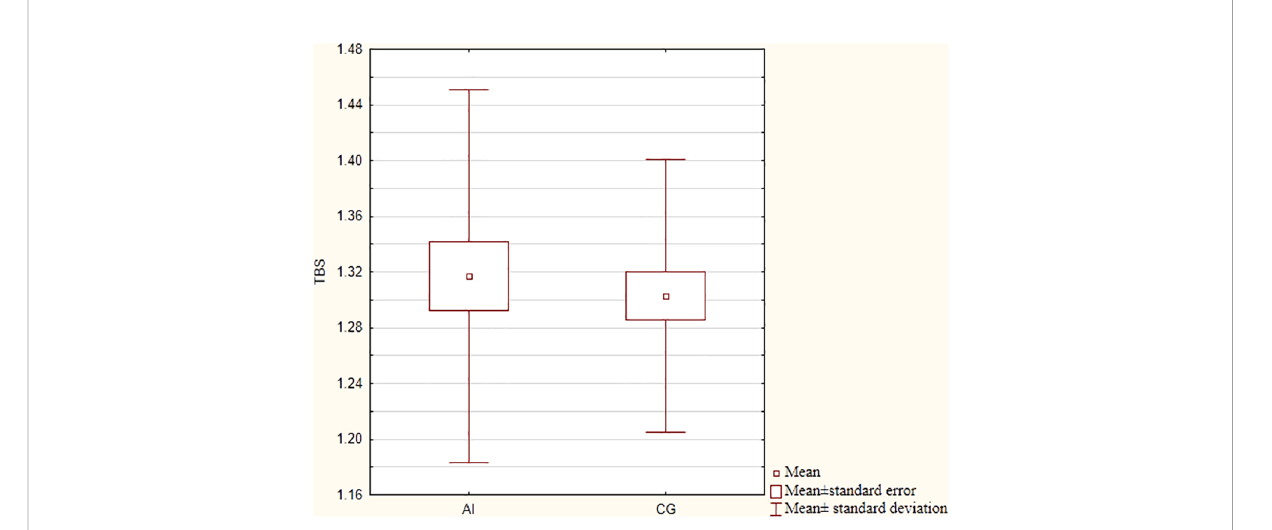
FIGURE 1 TBS values in patients with primary adrenal insuf fi ciency and control group. TBS, trabecular bone score; AI, adrenal insuf fi ciency group; CG, control